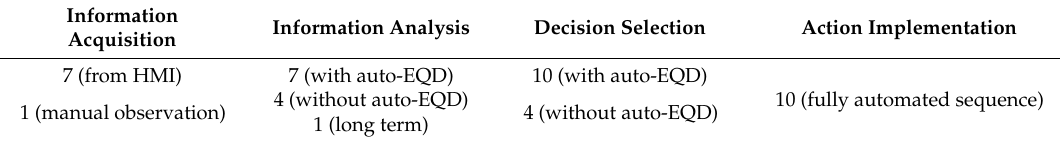
Table 8. Summary of current level of EQD automation, based on our research framework. Level 1 means that the system offers no assistance, humans must take all decisions and actions. Level 4 means that the system suggests one alternative. Level 7 means that the system executes automatically, then informs the human. Level 10 means the system acts autonomously, ignoring the